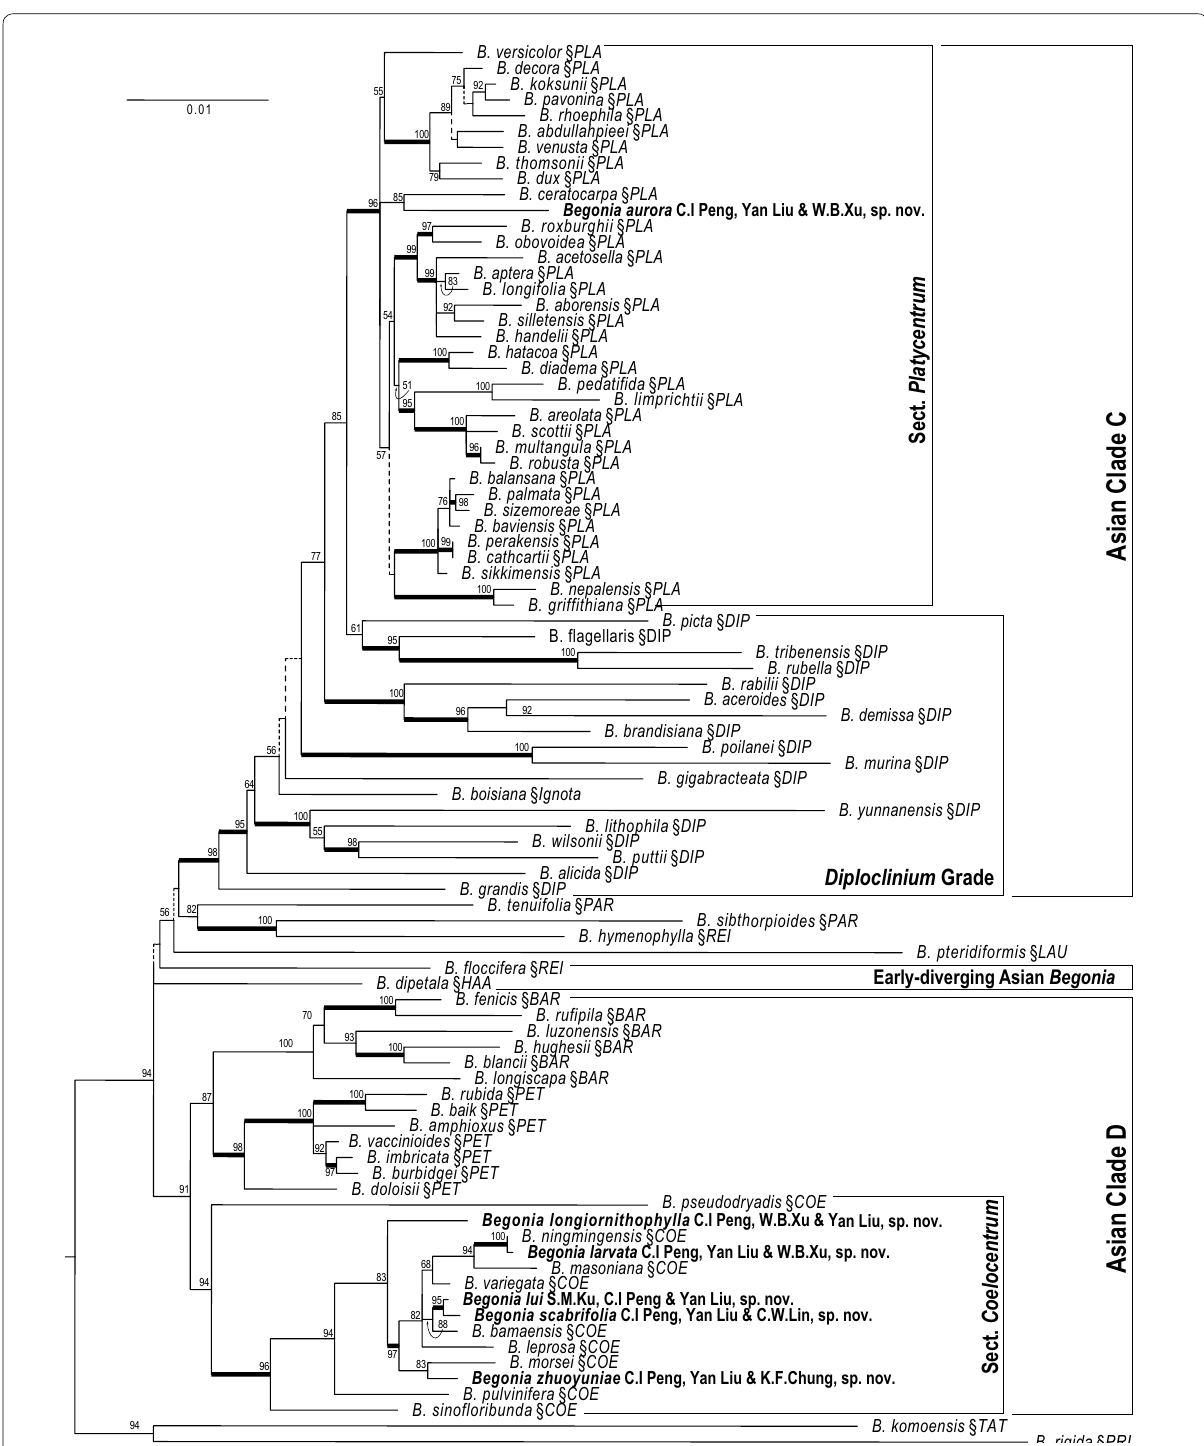
Fig. 2 A maximum likelihood phylogram based on plastid DNA sequences of ndhA , ndhF ‑ rpl32 , and rpl32 ‑ rpL32 ‑ trnL and bootstrap support values (> 50). See text for abbreviation of section